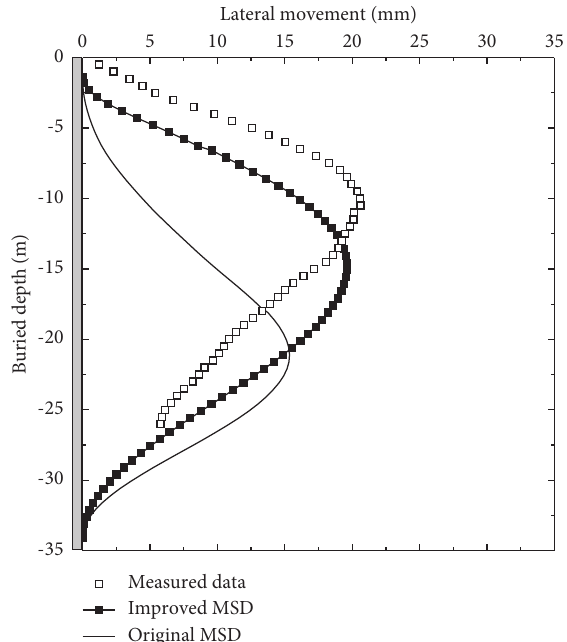
Figure 16: Comparison of measured data and calculated